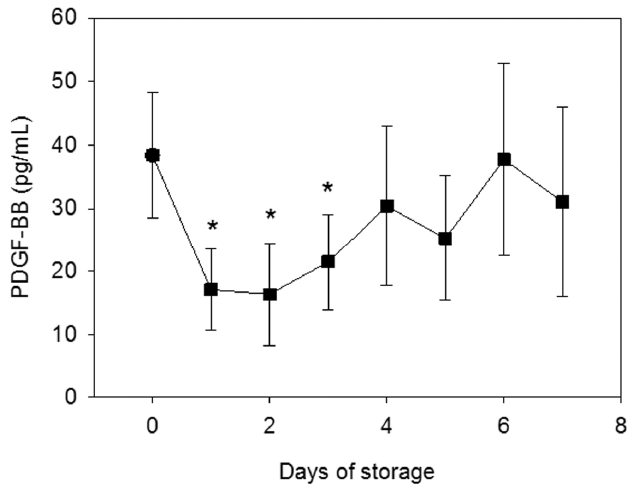
Figure 7. Time-dependent changes in the concentration of PDGF-BB extracted from PRFM samples that were prepared from stored WB samples and compressed to squeeze out PRFM exudates. * p < 0.05 as compared with fresh WB samples as controls ( n = 8).